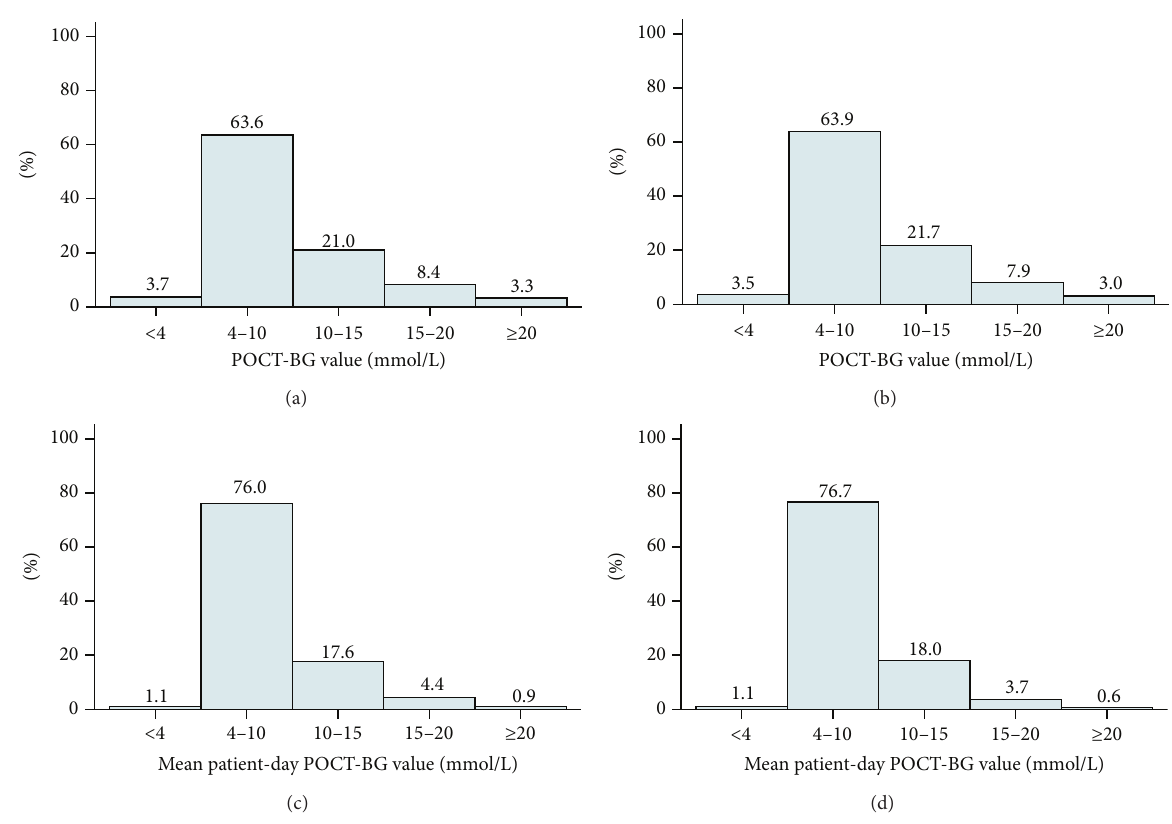
Figure 1: Vertical bar graphs showing the percentage of results by glucose level: (a) preimplementation POC-BG values; (b) postimplemen- tation POC-BG values; (c) preimplementation mean patient-day weighted POC-BG values; and (d) postimplementation mean patient-day weighted POC-BG values.